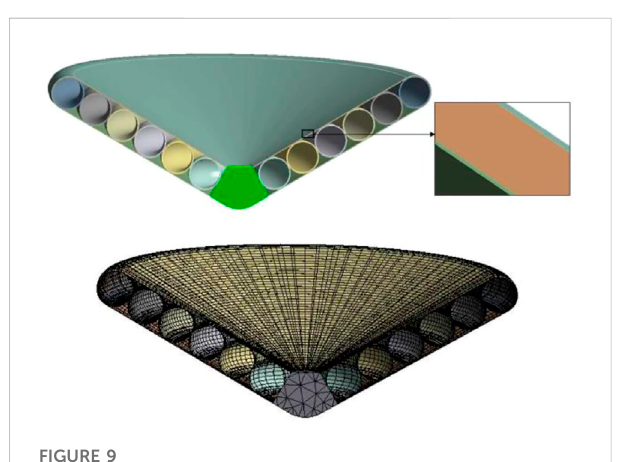
FIGURE 9 3D model and grid of the fl exible in fl atable